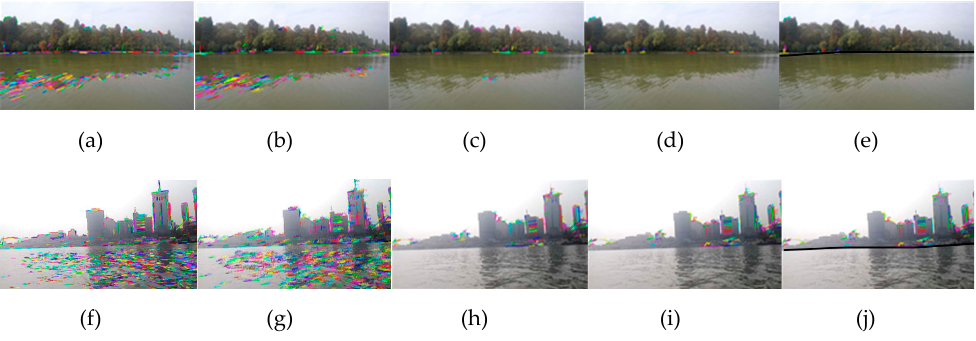
Figure 14. The WSL generation experiments for large scenes: ( a – e ) is experiment III in the East Lake, which is line segment extraction, line segment matching, line segment pool rough selection, line segment pool fine selection and the WSL generation. ( f–j ) is experiment IV, which is in the Yangtze River.